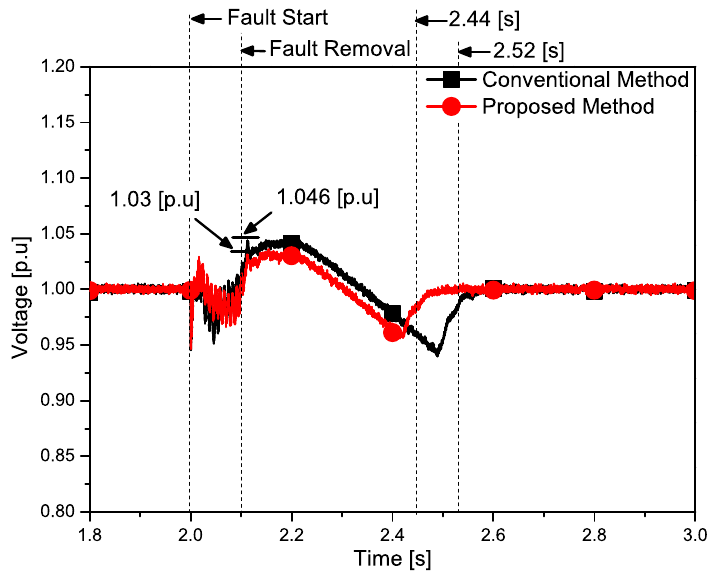
Figure 12. The DC voltage of the MVDC when applying the CR.